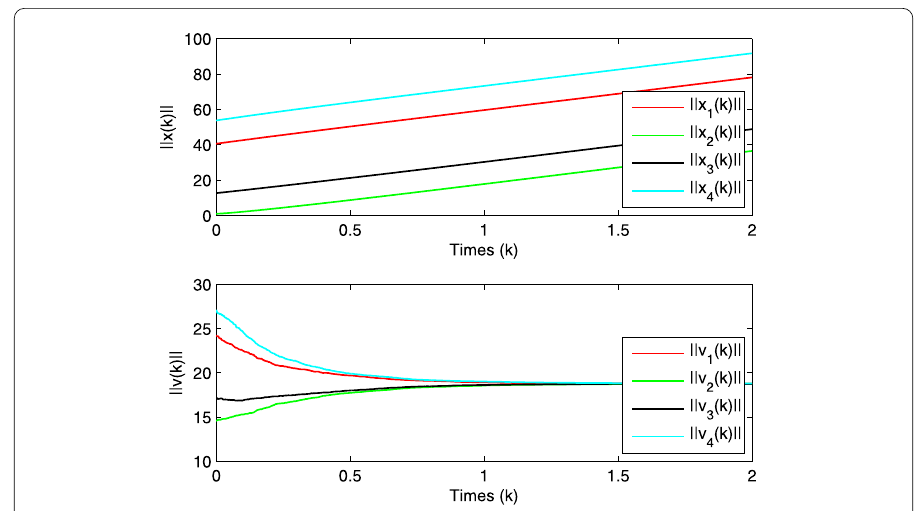
Figure 5 The norms of position and velocity trajectories with α = 0.5 in Case 2